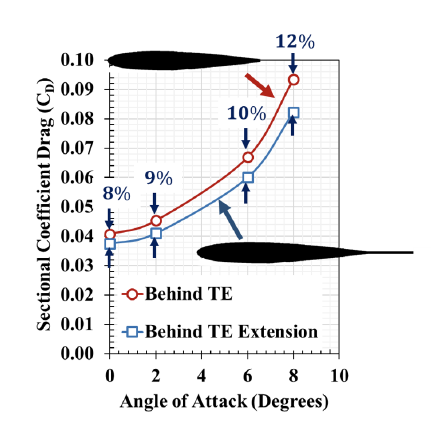
Figure 12. Variation of coefficient drag estimation behind the trailing edge and behind the TE extension as a function of angle of attack. The estimated drag coefficient behind the TE extension is lower than the drag coefficient behind the